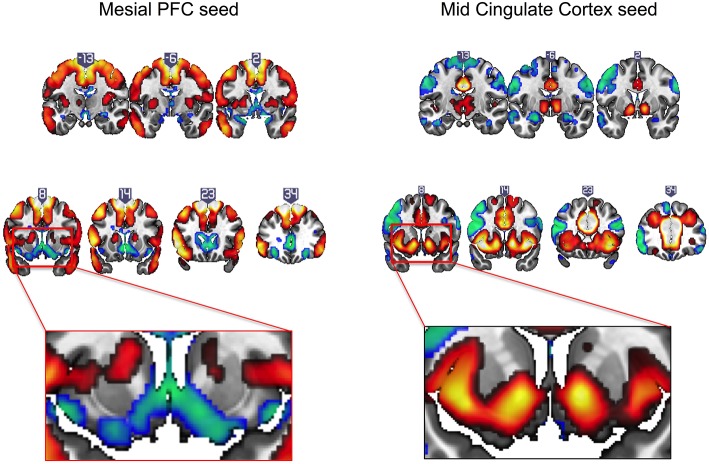
Intrinsic resting state connectivity maps for mesial prefrontal cortex (PFC) and mid cingulate cortex seeds to whole brain in healthy controls. Positive (yellow-red) and negative (green-blue) functional connectivity are displayed. The rectangular insets at y = 8 highlighting differences in direction of connectivity of the striatum are shown for the mesial PFC (bottom row, left) and mid cingulate (bottom row, right). Coronal images (y-values shown above image) are thresholded at whole brain family-wise error, corrected p < 0.05 on a standard MNI template.